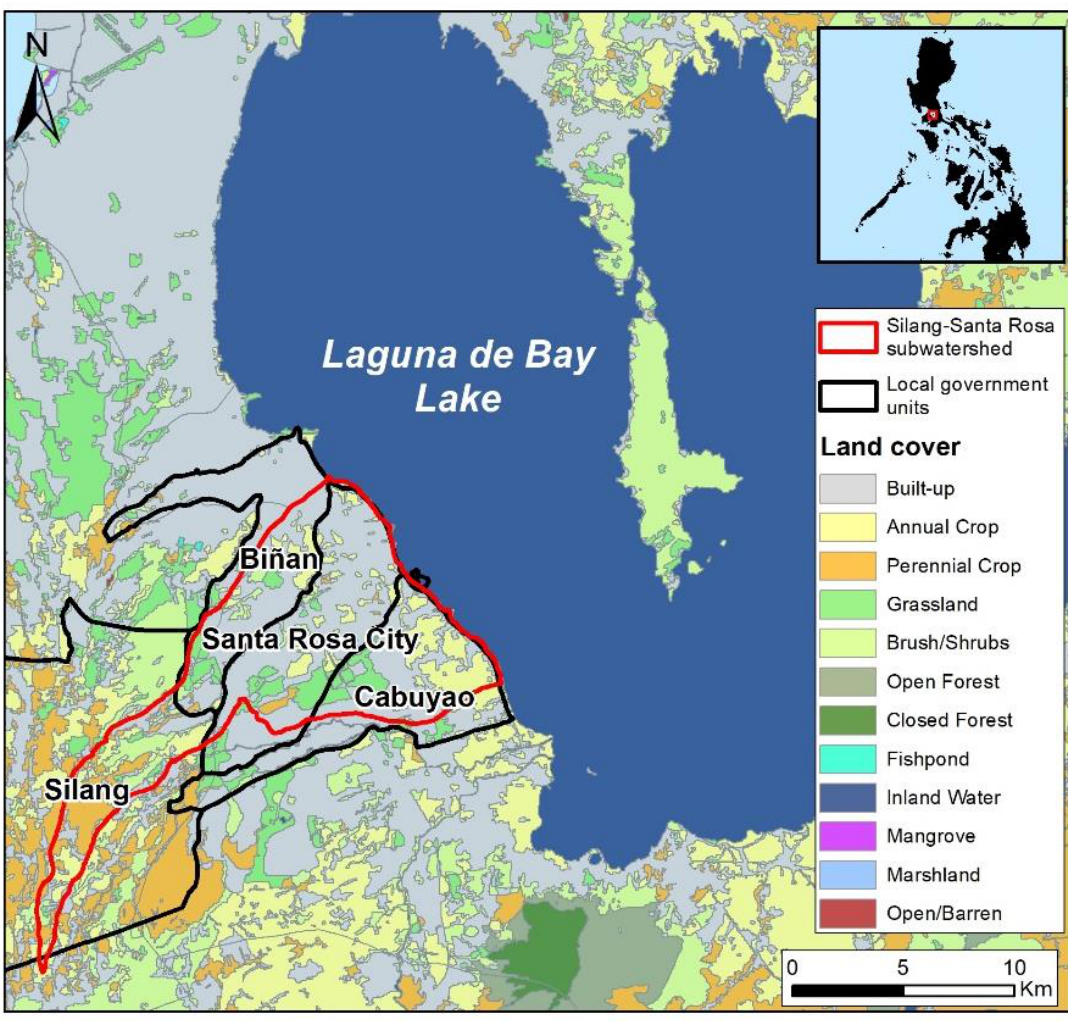
Figure 1. Santa Rosa watershed map.